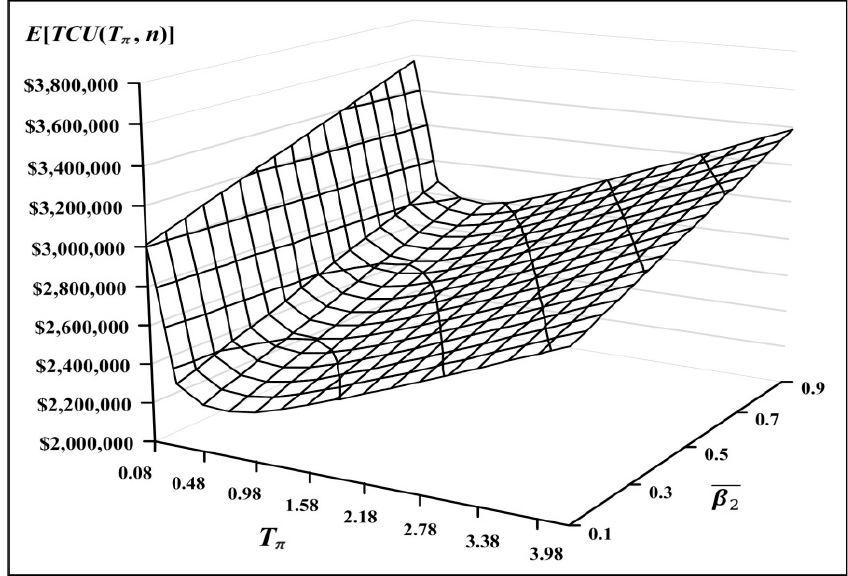
(cid:3364)(cid:3364)(cid:3364) on E [ TCU ( T π , n )].